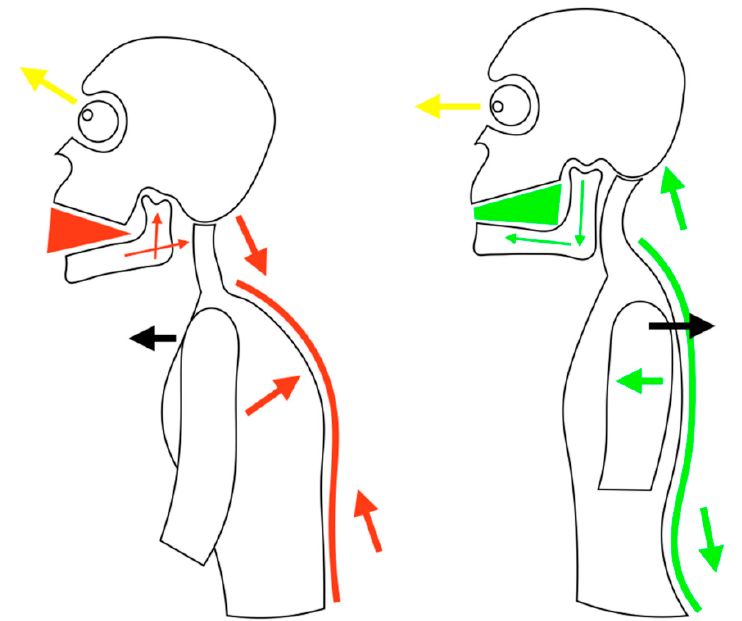
Figure 1. TMJ, posture and airways. Note how mandible position is strictly related with trunk posture. https://www.mdpi.com/2411-5142/4/3/58. By gentle concession of S. Sambataro [3]